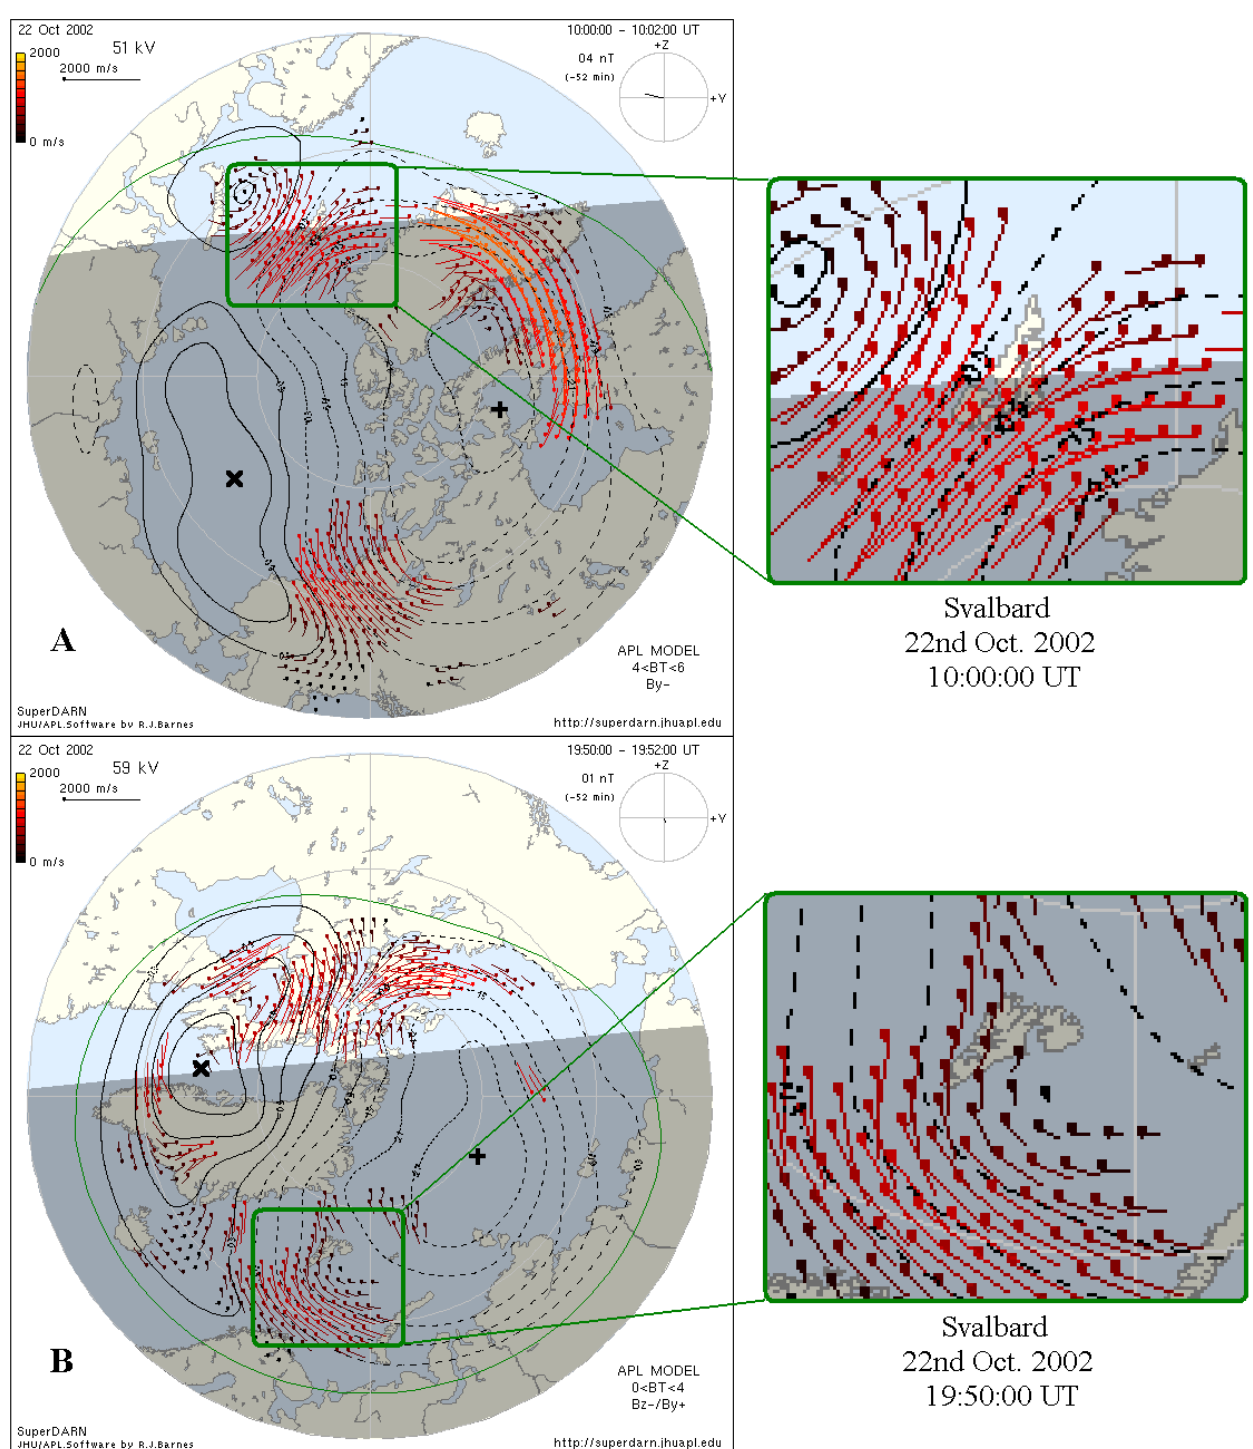
Fig. 3. Illustration of Svalbard’s location under, (a) the intake of Solar EUV ionized plasma near noon, and (b) plasma streaming out of the polar cap near